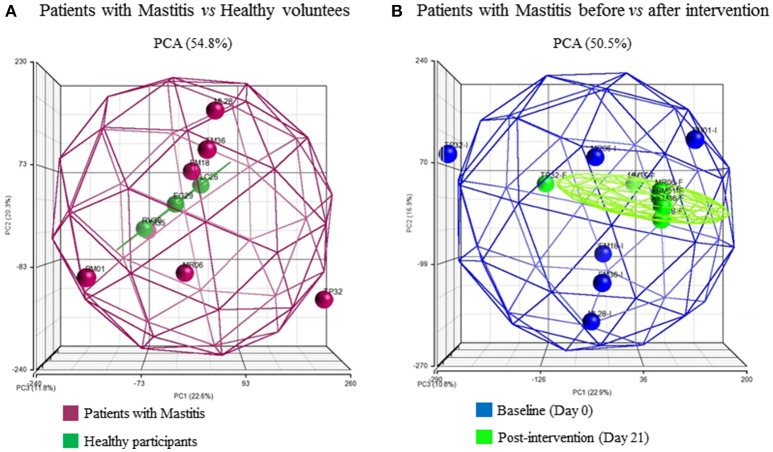
Three-dimensional representation according to principle component analysis (PCA) of the microarray differential gene expression significant data. Spheroids collect the at least 95% of the samples in each comparison and each sphere represents a patient: (A) patients at baseline, Mastitis vs Healthy groups, (B) Mastitis patients at day 0 vs. day 21 post-intervention with the probiotic. The color of the patients represents their health status or time-point respectively.